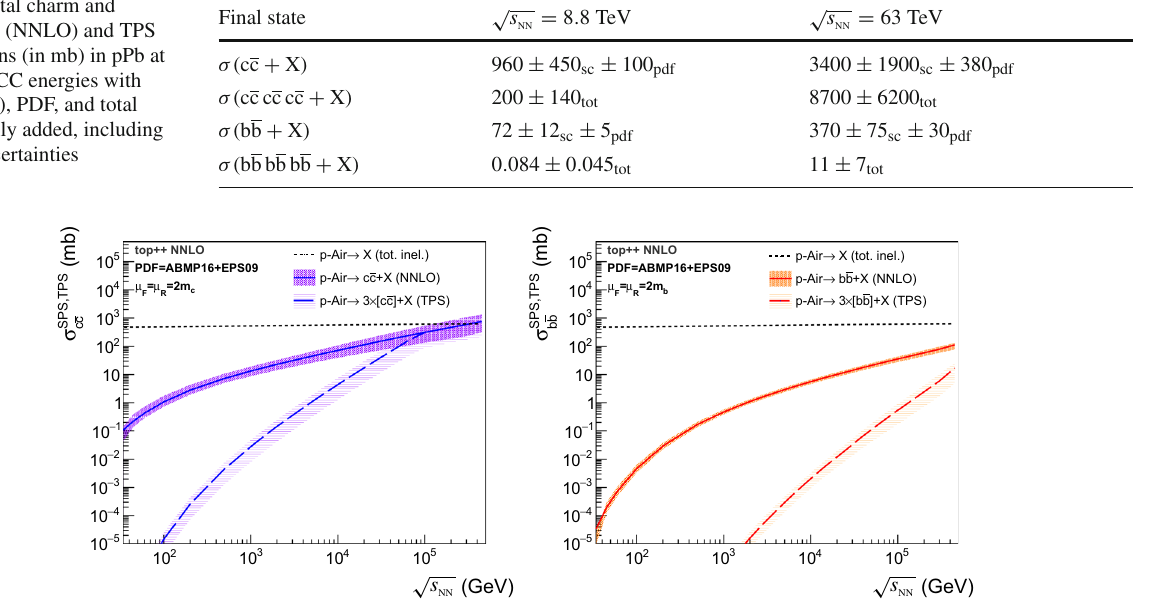
to the total inelastic p–Air cross section (dotted line). Bands around curves indicate scale, PDF (and σ eff , tps , in the TPS case) uncertainties added in quadrature